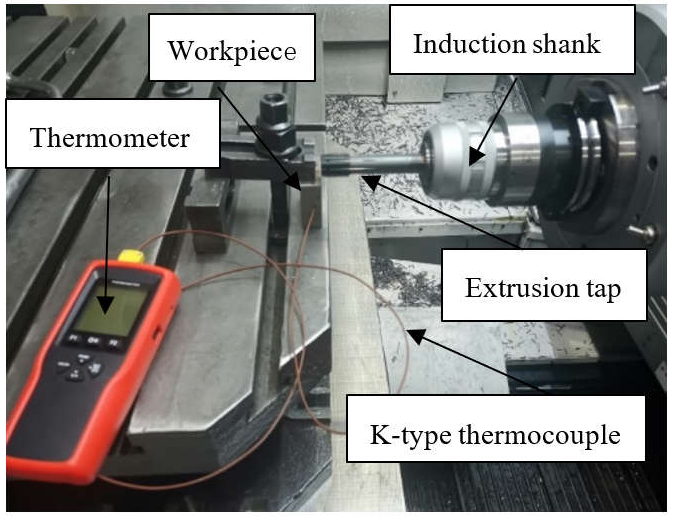
Figure 4. Experiment of thread